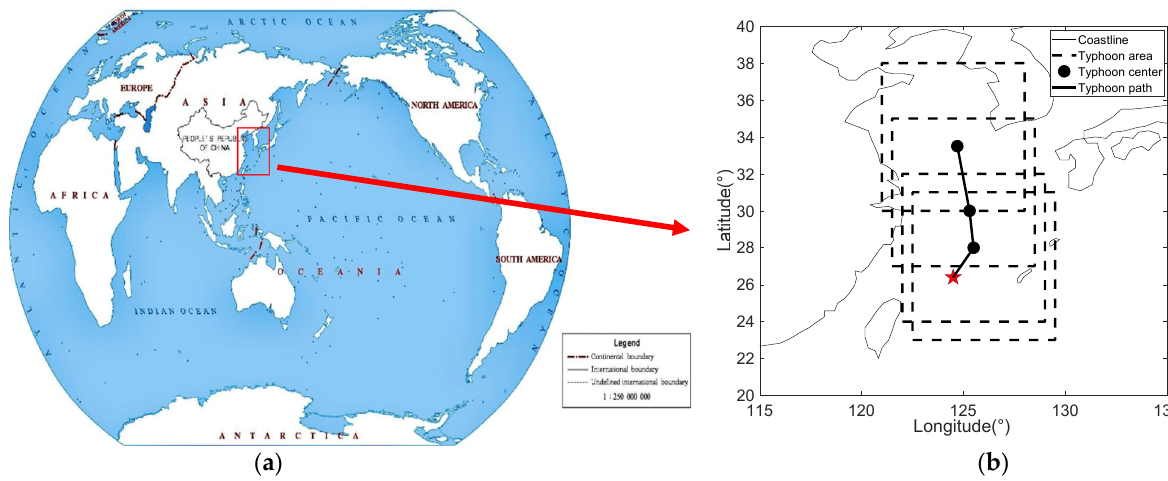
Figure 5. ( a ) Location of the region for performance evaluation (world map: preview number: GS (2016) 1563); ( b ) Typhoon Bavi (2020.8.22~2020.8.26) moving track map and daily interested area. Table 1. 2020.8.22~2020.8.26 typhoon area latitude and longitude selection range.